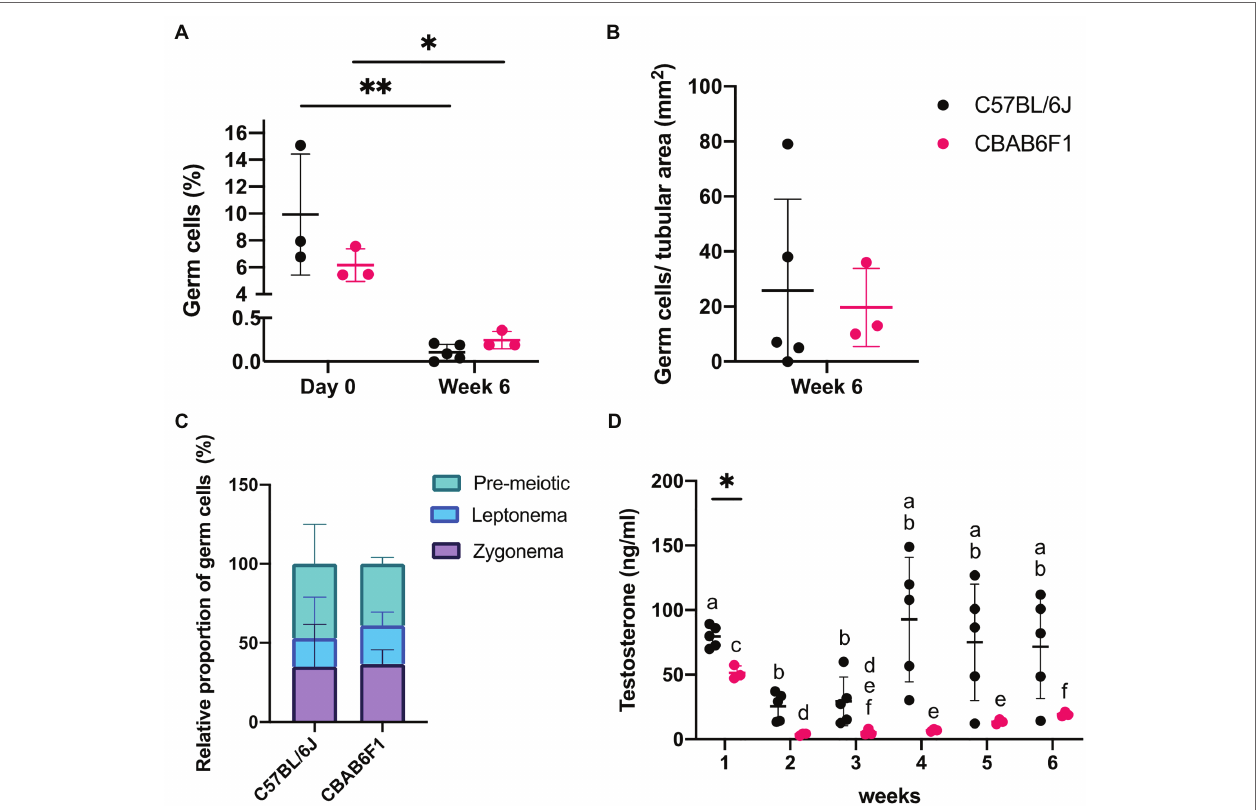
FIGURE 3 | Changing germ cell dynamics and detection of steroidogenic activity in primary 1LS-TOs. (A) Effect of time-course and mouse strain (C57BL/6 J: n = 5, CBAB6F1: n = 3) on relative percentages of germ cell numbers. Asterisks show statistical significance. (B) Absolute germ cell numbers per mm 2 in primary TOs in 1LS at week 6. (C) Relative proportion of pre-meiotic and meiotic leptonema and zygonema in primary TOs in 1LS at day 0 and week 6 of culture. (D) Comparison of testosterone secretion in primary TOs between mouse strains at each timepoint. Different superscripts (a–f) show statistical significance over time within one mouse strain. Asterisk shows statistical significance between mouse strains on a specific time